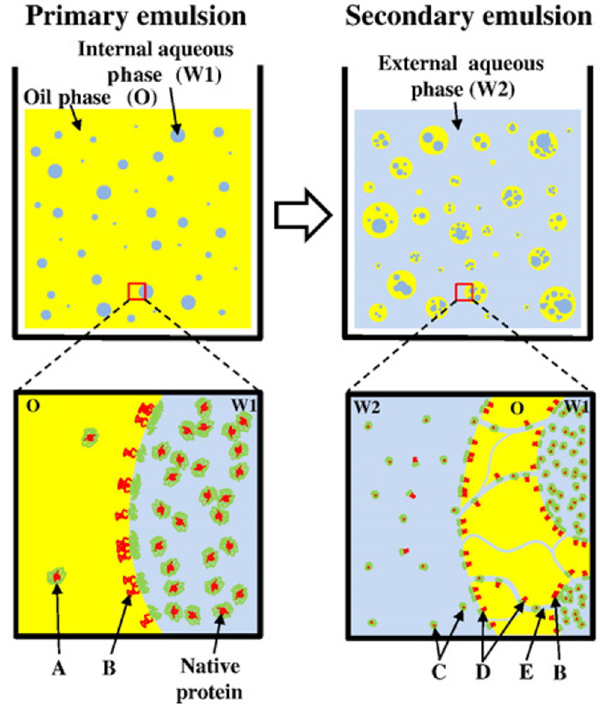
Figure 5. Typical W1/O/W2 double emulsion method to prepare microspheres containing protein drug ( upper panel ) and microscopic events during the fabrication process using solvent evaporation (SE)/extraction ( lower panel ). With negligible partition of protein into oil phase (A), the organic solvent–water interface during W1/O emulsion results in protein denaturation (B). During generation of secondary emulsion, water channels connecting internal (W1) and external (W2) aqueous phases (E) allow proteins to escape from droplets (C) and provide more chances of protein denaturation by increased surface area of the oil–water interface (D). The water channels become pores (E) of microspheres (reprinted from [11] with permission, copyright Elsevier 2010).